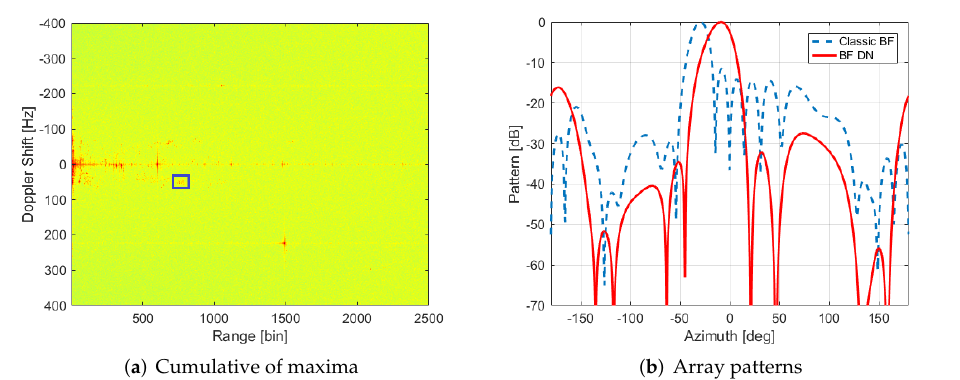
Figure 10. ( a ) Cumulative of maxima through the 158 CPIs in beam 1 with deterministic null genera- tion; ( b ) array pattern for the same beam and CPI 13 comparing the case of classical beamforming with the Deterministic Nulls (DN) generation one.